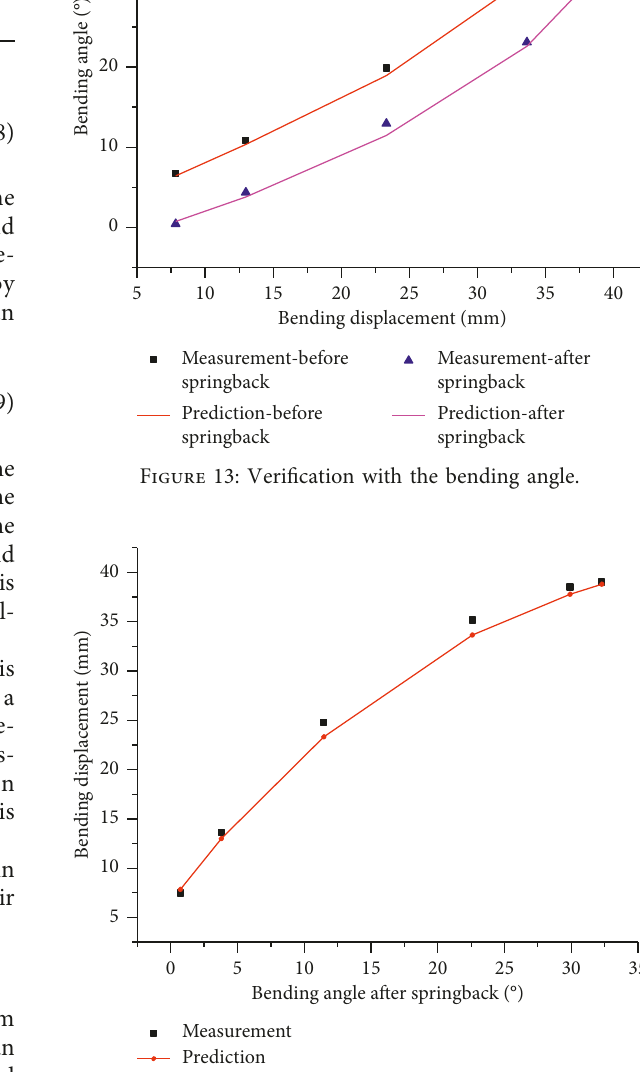
Figure 14: Verification with bending angle and bending displacement.